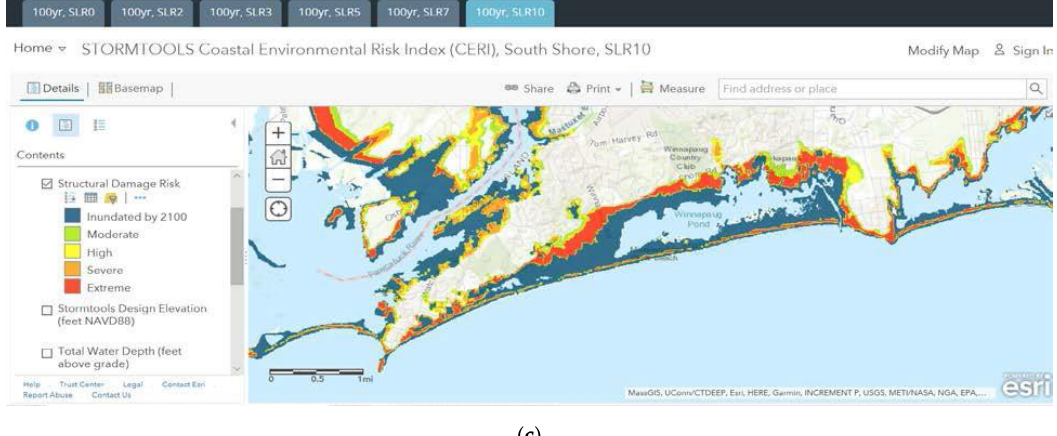
Figure 14. CERI predicted risk maps for 100 yr surge and varying SLR cases, none ( upper panel ), 5 ft ( center panel ), and 10 ft ( lower panel ) for the Southern RI shoreline, high resolution map of Misquamicut Beach and Westerly